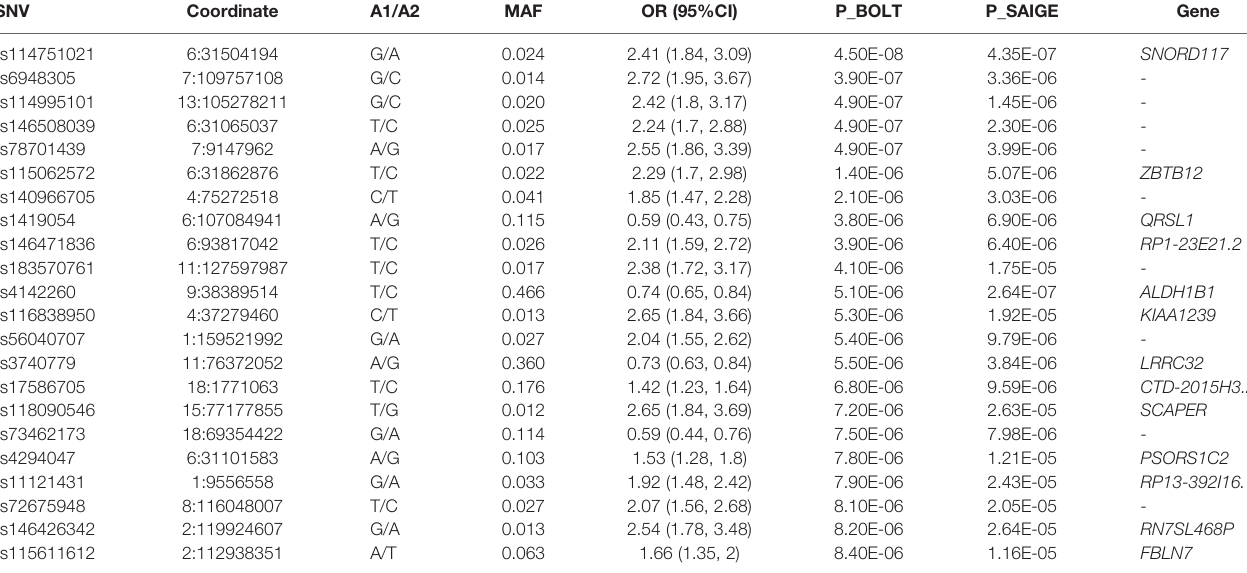
FIGURE 2 | Manhattan and QQ plots for GWAS results associated with CDI in antibiotic treated patients with European ancestry. A linear mixed model regression adjusted for the covariates including sex, cohort, PPI, chemotherapy, T2DM, and Index Age were conducted by BOLT-LMM. Top variants with original p value < 5×10-8 were labeled. The genomic in fl ation factor, l GC, equals to 1.004, suggesting no evidence for systematic in fl ation of genome-wide test TABLE 2 | Top CDI-associated variants in the antibiotic subgroup.